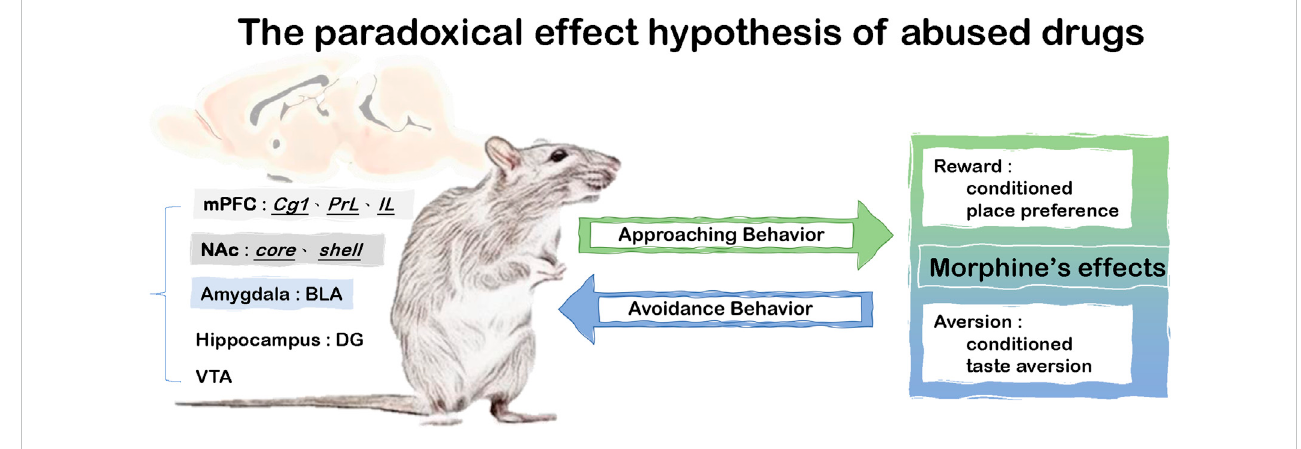
FIGURE 1 The paradoxical effect hypothesis of abused